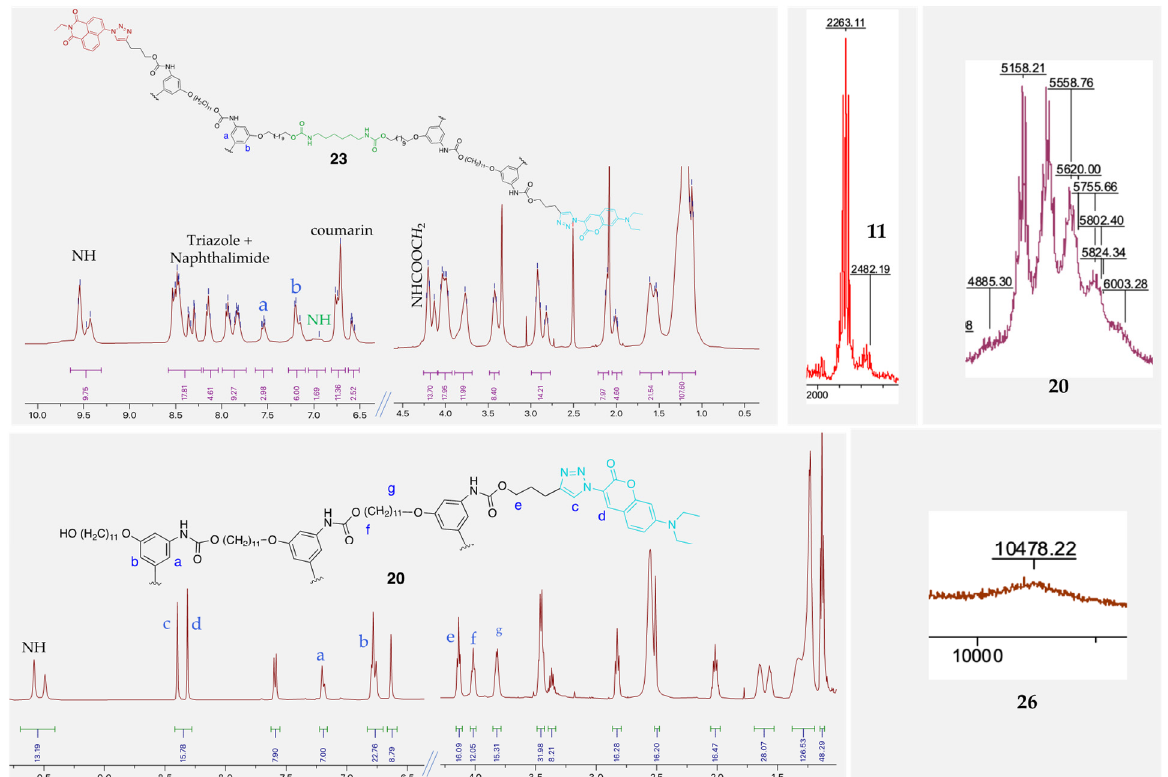
Figure 1. Representative NMR spectrum of a Janus dendrimer showing G2 dendrimer, 23 . The integration shows only a half-portion of compound structure (top left). Representative NMR of a late-stage-modified dendron by CuAAC showing G3 dendron, 20 (bottom left) (the integration involves the full compound structure). MALDI-TOF-MS spectra of different dendrons ( 11 and 20 , top right) and dendrimer ( 26 , bottom right).